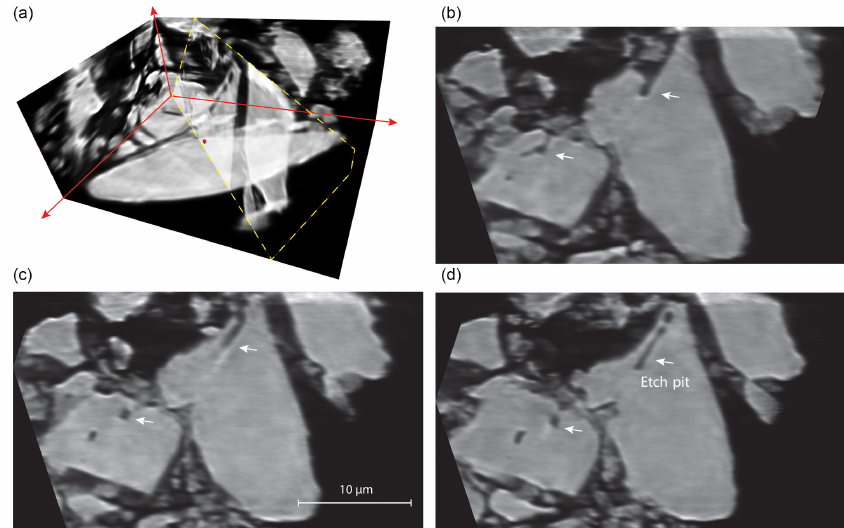
Figure 11. Reconstructed images from the nanotomography data of the SGC sample’s cup wall demonstrate the existence of etch pits and dissolution channels (white arrows) formed in the olivine grain. The precipitates (darker grey) partially fill the pore space (black) between olivine grains (lighter grey). The yellow dashed line (a) marks the orientation of the cross sections (b–d) . The vertical distance between each 2-D cross section is ∼ 600nm. Reacting fluid causes a preferential dissolution of the grain which develops small channels that dig into the grain. These features provide a fluid path and eventually break grains, exposing new reactive surfaces.